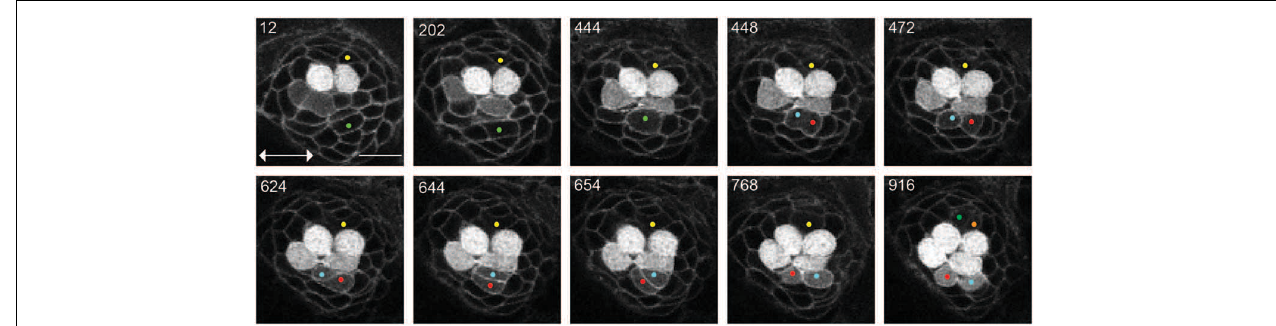
FIGURE 2 | UHCPs division and planar cell inversion. Frames from Supplementary Movie 1 at the time-points indicated A 916 (cid:2) min series of confocal images of a double-transgenic Tg[Cldnb:mGFP;SqET4] regenerating neuromast. Two prospective UHCPs were identified retrospectively by playing the time series backwards and labeled with a yellow and green dot. Each UHCP eventually divides into a pair of sister hair cells, labeled in Cyan/Red and Green/Orange, respectively. On minute